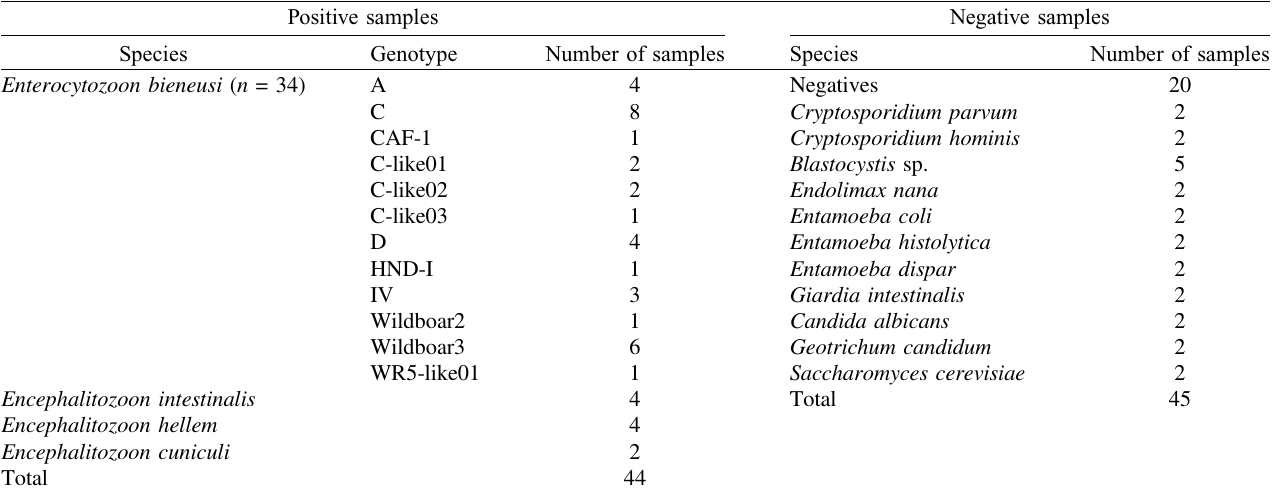
Table 1. Clinical stool samples used in this